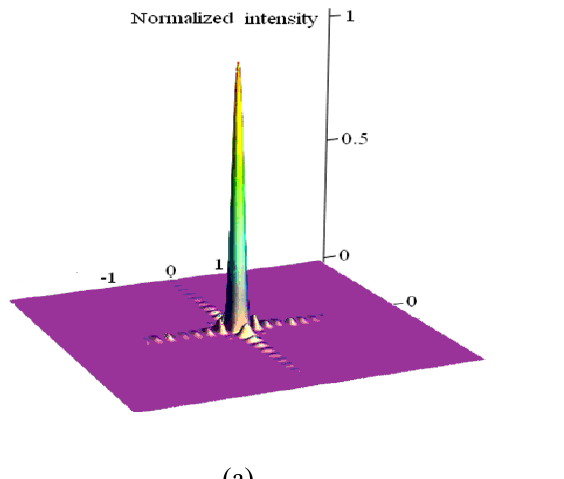
Figure 3. (a) Intensity of the zero order, when phase difference is 2 m π . (b) Intensity of the zero order, when phase difference is (2 m +1) π